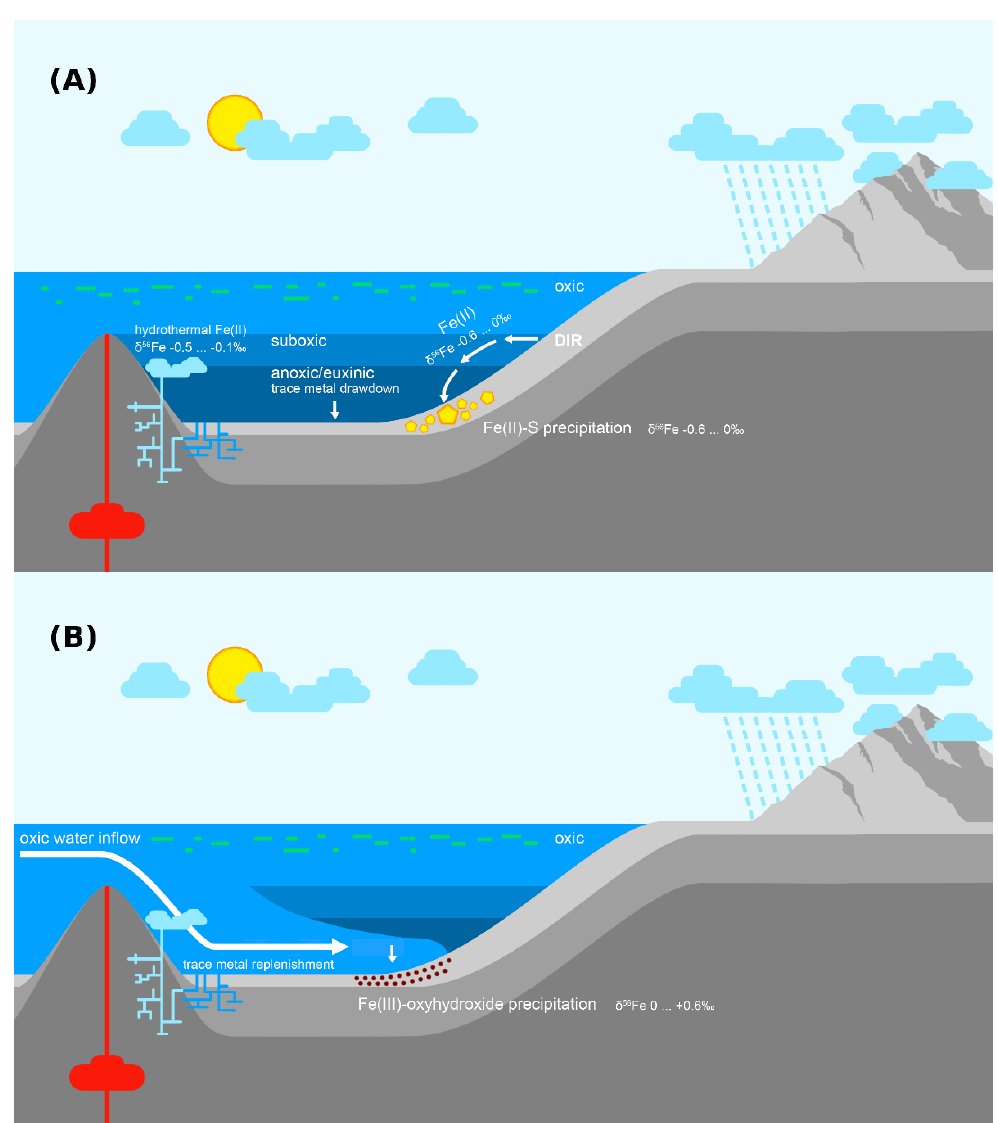
Figure 6. An interpretation of the hydrographic and redox conditions in the Onega Basin during the deposition of the upper Zaonega Formation. ( A ) Hydrographic restriction rendered the basin redox-stratified. Dissimilatory iron reduction (DIR) converted detrital Fe(III) phases in reducing sediments into Fe(II) with negative δ 56 Fe values. Dissolved Fe(II) with negative δ 56 Fe values may also have been contributed by hydrotherms. If overlain by suboxic waters, some of this Fe(II) flux escaped into the water column, was transported into deeper, anoxic waters, and deposited as Fe(II)-sulphides. ( B ) Periodically, the basin experienced oxic water inflow events, which caused dissolved Fe(II) in the basin to be oxidised, precipitating Fe(III) oxyhydroxides with sometimes positive (up to +0.6‰) δ 56 Fe values.